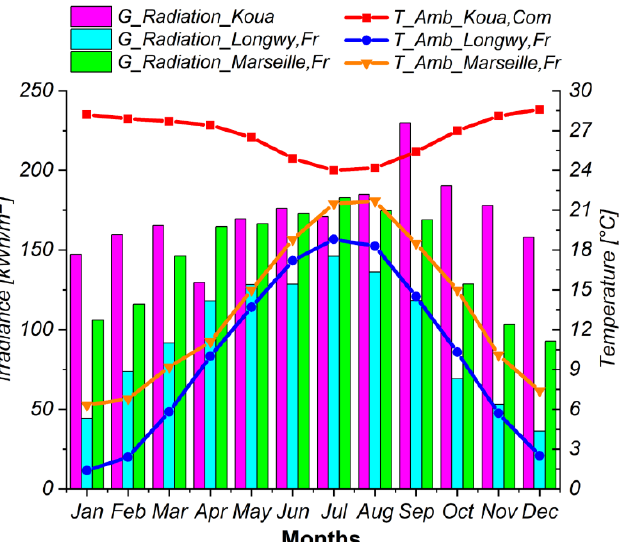
Figure 4. Mean values of solar radiation and ambient temperature in Koua, Marseille, and Longwy cities.